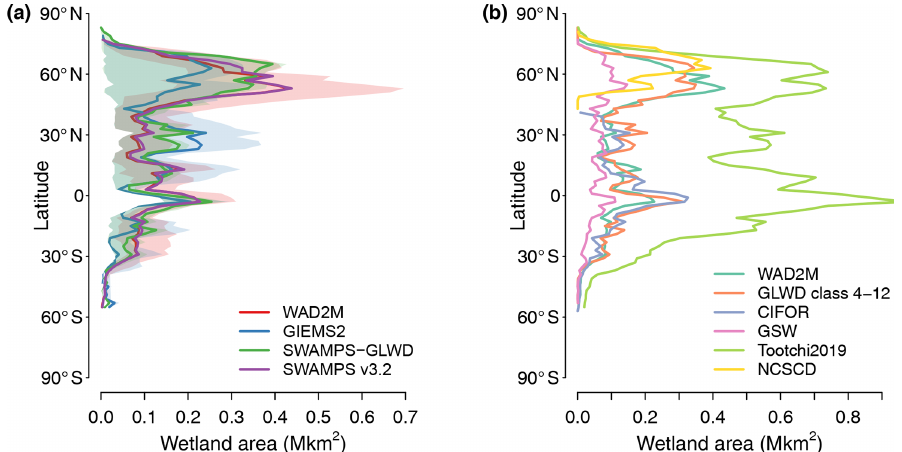
Figure 4. Latitudinal gradient of WAD2M in comparison to existing wetland/inundation products. (a) Comparison with the dynamic inun- dation products GIEMS2 and SWAMPS-GLWD (previous version of WAD2M). The solid lines represent long-term mean annual maximum (MA max ) with upper (MA Lt ) and lower (MA min ) range of inundated area marked as shaded area. (b) Comparison with static inventory datasets. To make it a fair comparison, lakes, rivers, and reservoirs (i.e., class 1–3 in GLWD) were excluded from GLWD. Lakes (code 4) were excluded from the topographic index (TCI) version of the global wetland composite map from Tootchi et al. (2019) (denoted as Tootchi2019). The wetland area is calculated by a 2 ◦ latitudinal